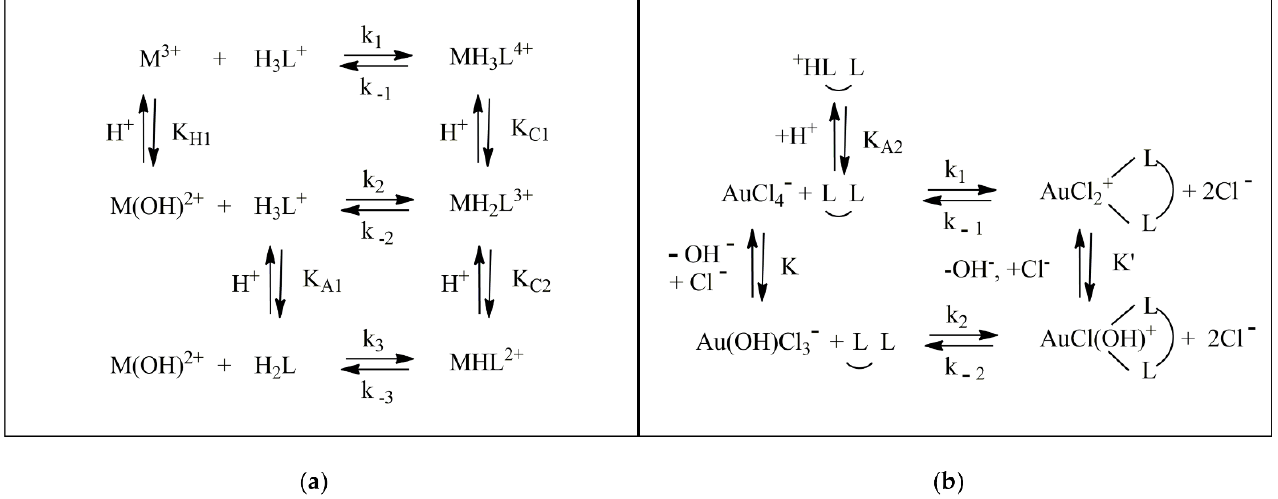
Figure 7. Example of ( a ) a general reaction mechanism where hydroxo species are supposed to be active together with the possible protonation of the ligand and ( b ) the case of chloride-dependent mechanisms in the presence of Au 3+ salts. Figure 7a adapted with permission from reference [77]. Copyright 2008 American Chemical Society. Figure 7b adapted with permission from reference [80]. Copyright 2016